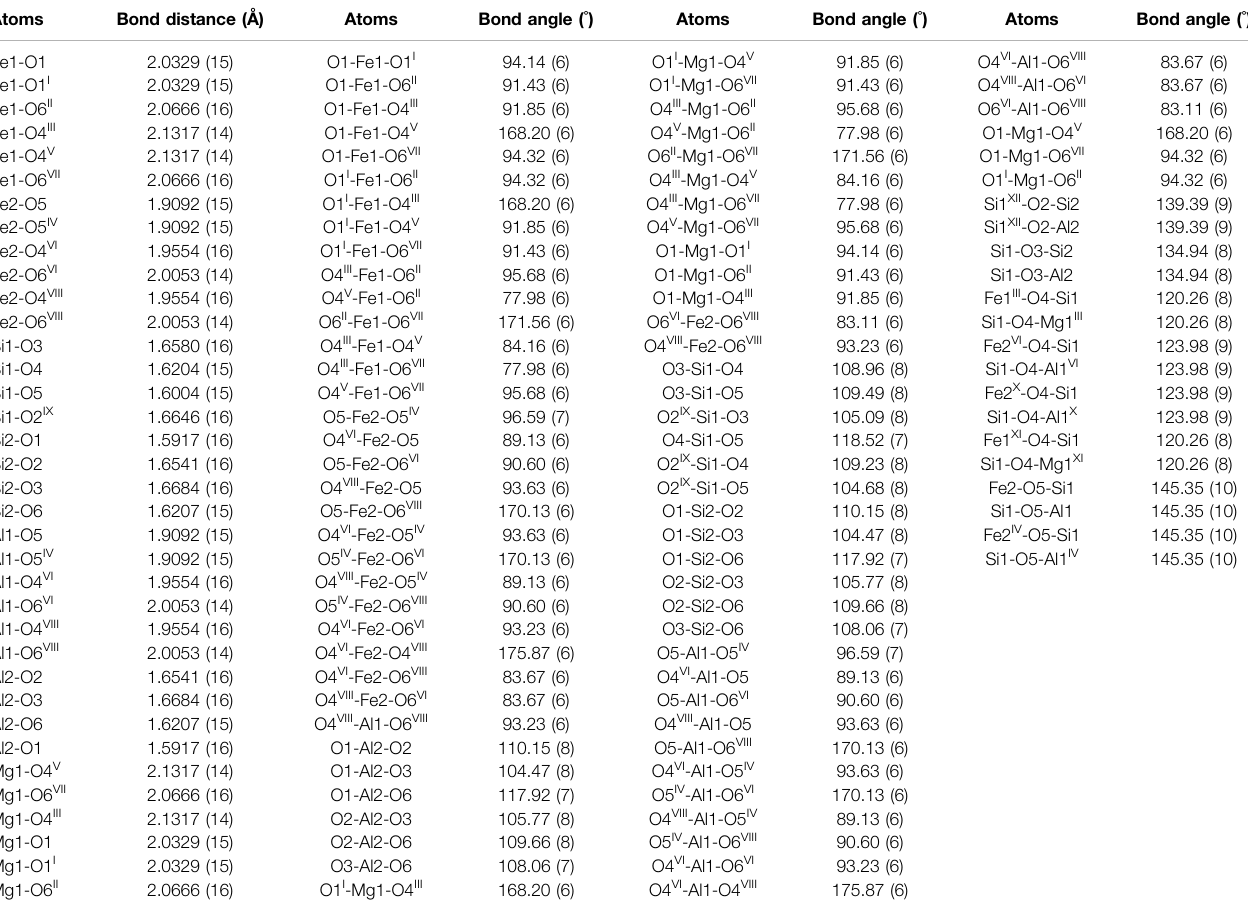
TABLE 4 | Selected bond distances (Å) and angles ( o ) for omphacite. Atoms